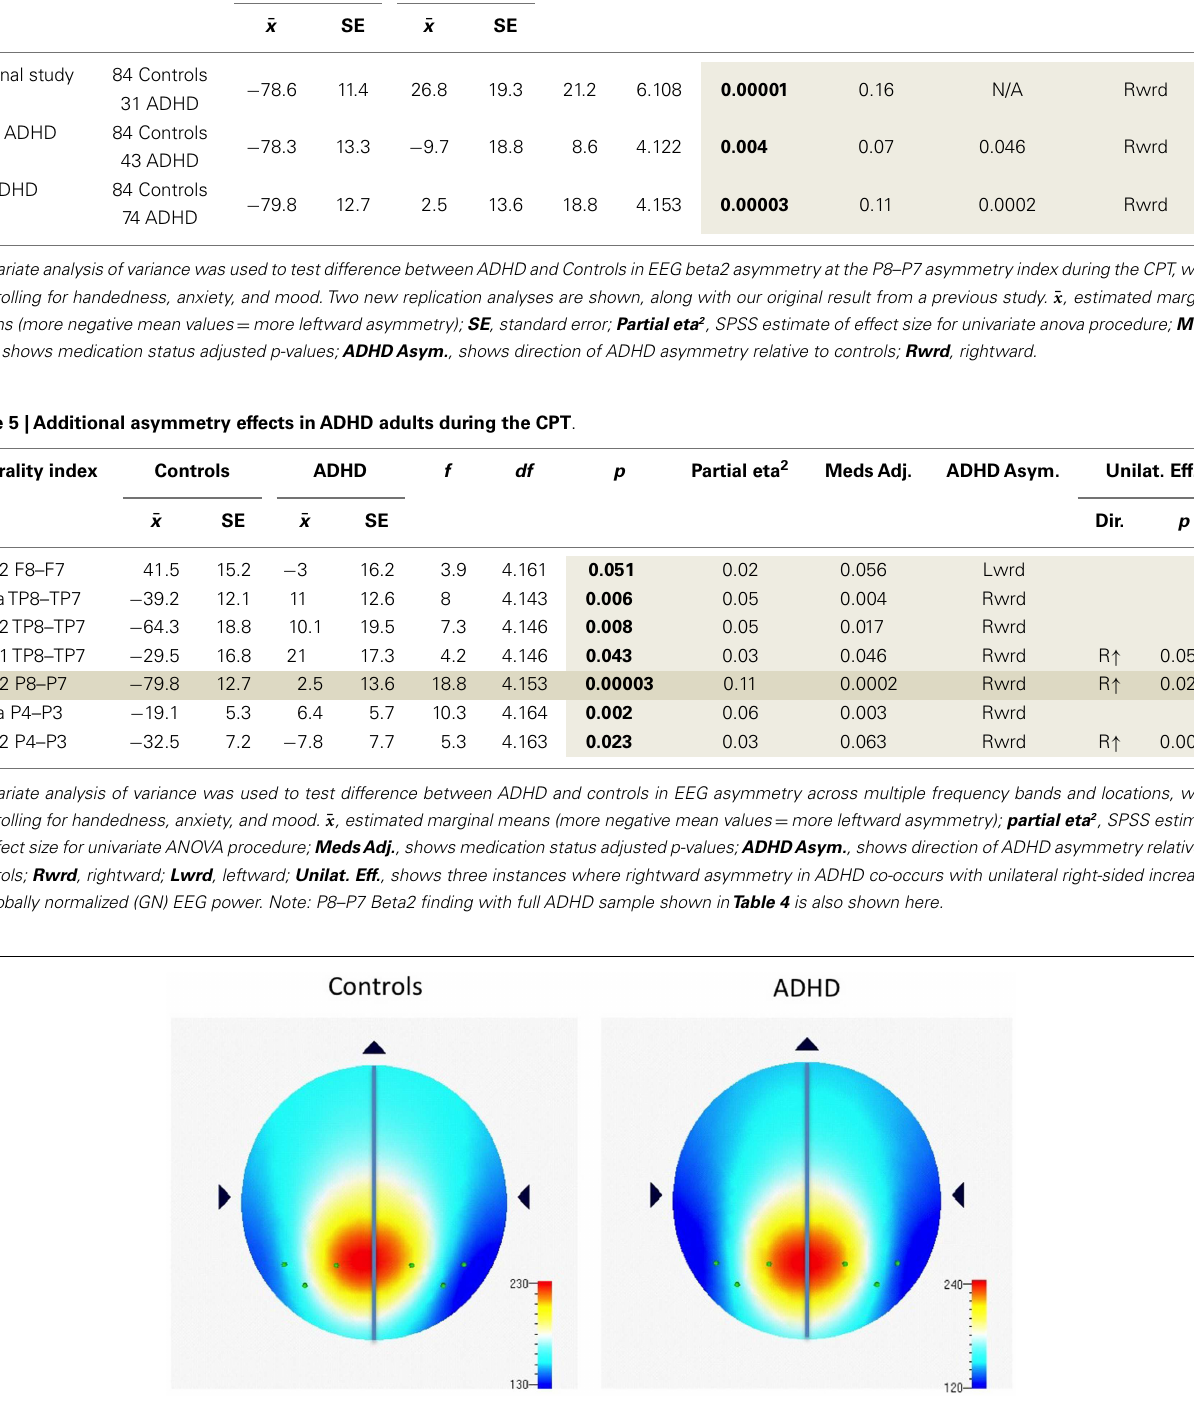
FIGURE 1 | Distribution of absolute power in beta2 frequency band (16–21Hz) among parietal electrodes comprising parietal asymmetry indices . Figure 1 shows EEG data recorded during the CPT, and indicates the